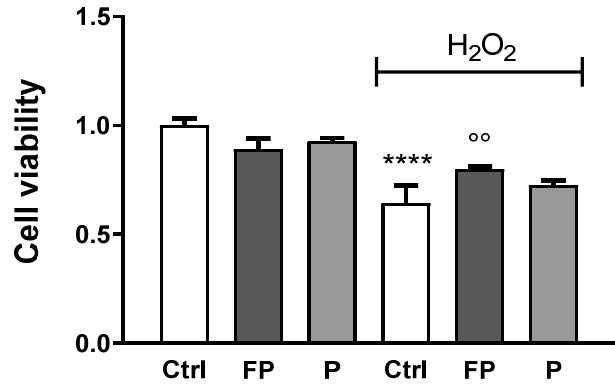
Trypan Blue was used to determine the viability of HUVECs incubated with H 2 O 2 (300 µ M) for 24 h, following treatment with FP and P solutions (10 µ g/mL) for 24 h. As expected, treatment with H 2 O 2 reduced cell viability of HUVECs and FP, but not P, significantly counteracts this effect (Figure 3).